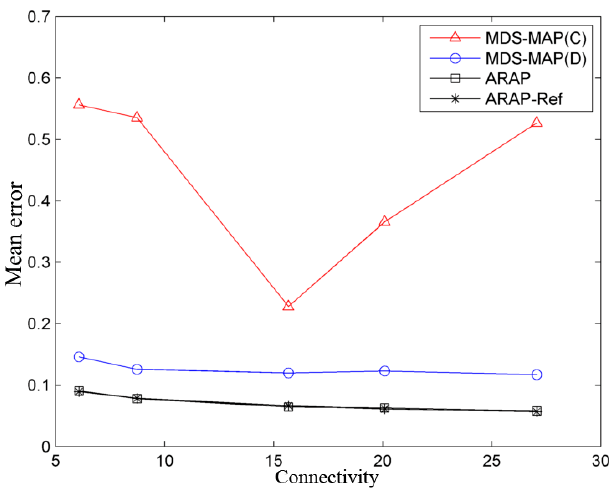
= 5%, andthreeanchornodes.